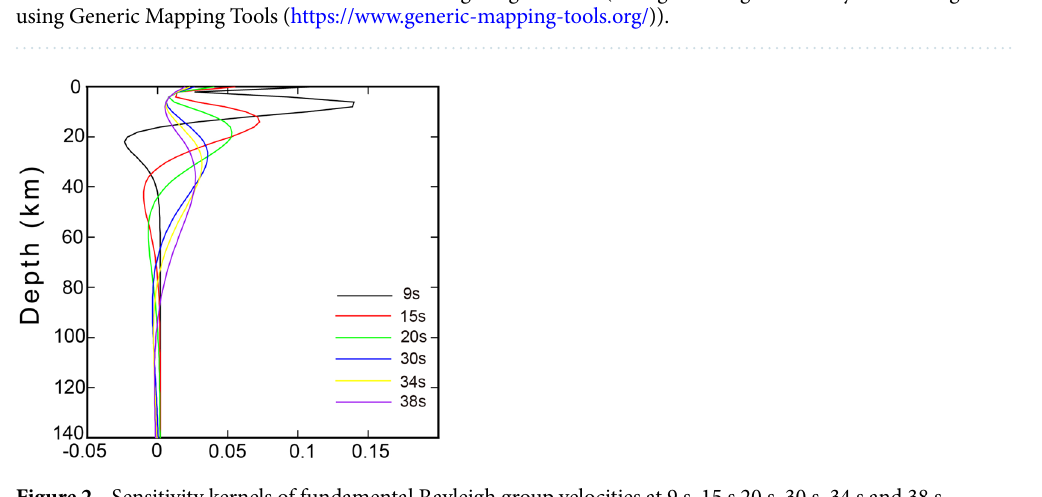
Figure 2. Sensitivity kernels of fundamental Rayleigh group velocities at 9 s, 15 s 20 s, 30 s, 34 s and 38 s. AK135 model 36 is adopted for calculation, and the crustal thickness is set at 36 km [the figure was generated by Chuansong He using Generic Mapping Tools (https:// www. gener ic- mappi ng- tools.